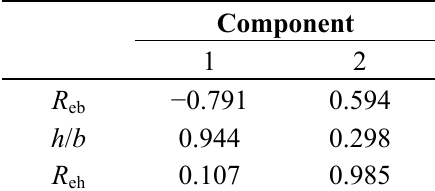
Table 7. Rotated component